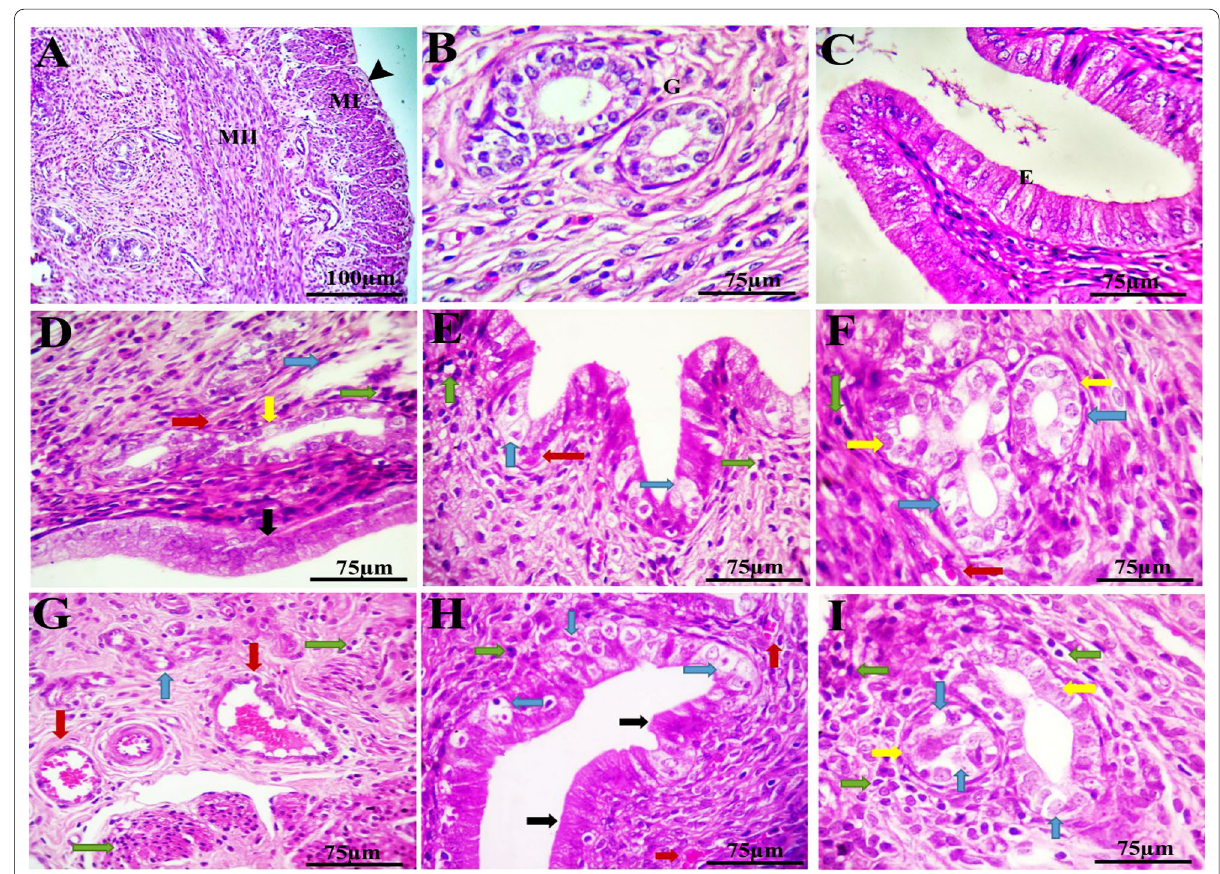
Fig. 4 Photomicrographs of a uterine section (H&E stain, n 3 from each group). Control ( A – C ): normal longitudinal muscle myometrium (MI), = circular muscle myometrium (MII), endometrial gland (G), and inner endometrium (E). Low dose ( D – F ): degeneration of glandular epithelial cells and in the epithelial cells of endometrium itself (blue arrows), congested blood vessels in longitudinal muscle layer (red arrow), apoptotic cells with deeply stained pyknotic nuclei (green arrow), hyperplasia and disaggregation of epithelial cells of the luminal epithelium of endometrium layer (black arrow) and degeneration of endometrial glands with vacuolar degeneration (yellow arrow). High dose ( G – I ): high percentage of inflammation and dilated congested blood vessels (red arrow), high level of apoptotic cells with pyknotic nuclei (green arrow), vacuolar degeneration change (blue arrow). H Degeneration in epithelial cells of endometrium (blue